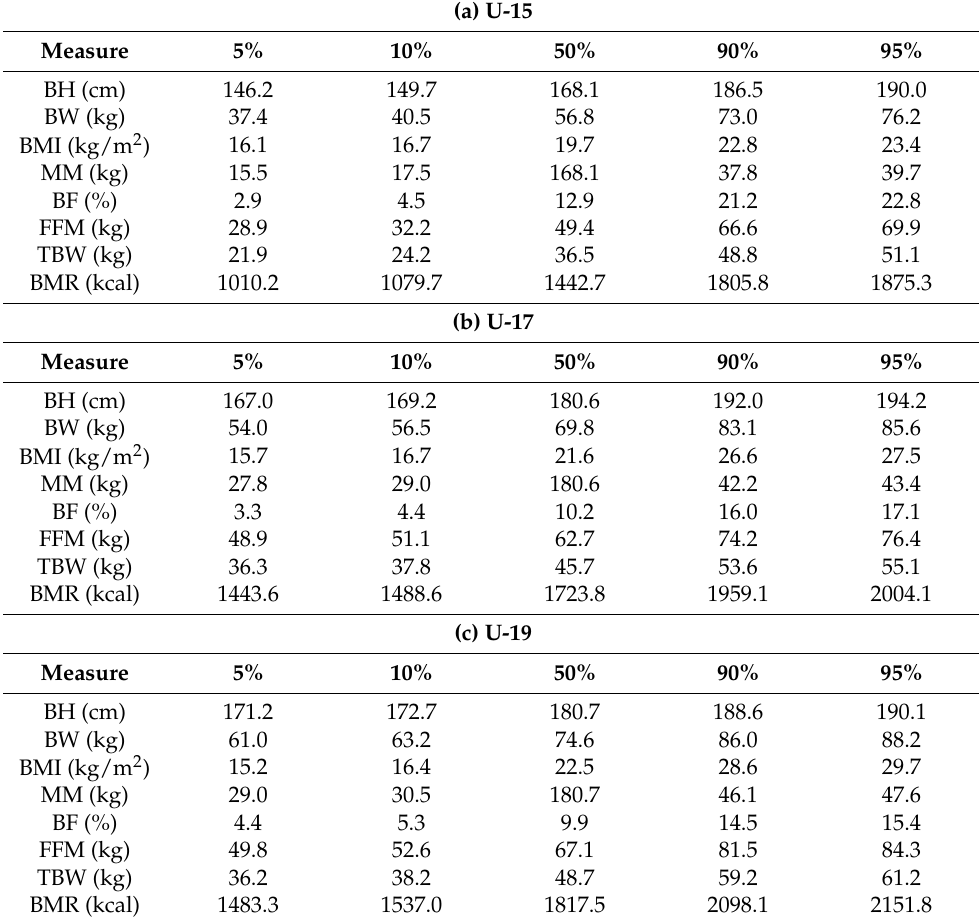
Figure 1. The 5th, 10th, 50th, 90th and 95th fitted centiles of ( a ) body height, ( b ) body weight, ( c ) body mass index, ( d ) basal metabolic rate, ( e ) fat free mass, ( f ) body fat mass, ( g ) skeletal muscle mass, ( h ) total body water for soccer groups. Table 4. The fitted centiles of body height (BH), body weight (BW), body mass index (BMI), skeletal muscle mass (MM), percentage of body fat mass (BF), fat-free mass (FFM), total body water (TBW) and basal metabolic rate (BMR) in ( a ) U-15, ( b ) U-17, ( c ) U-19 and ( d ) senior soccer players. (a)